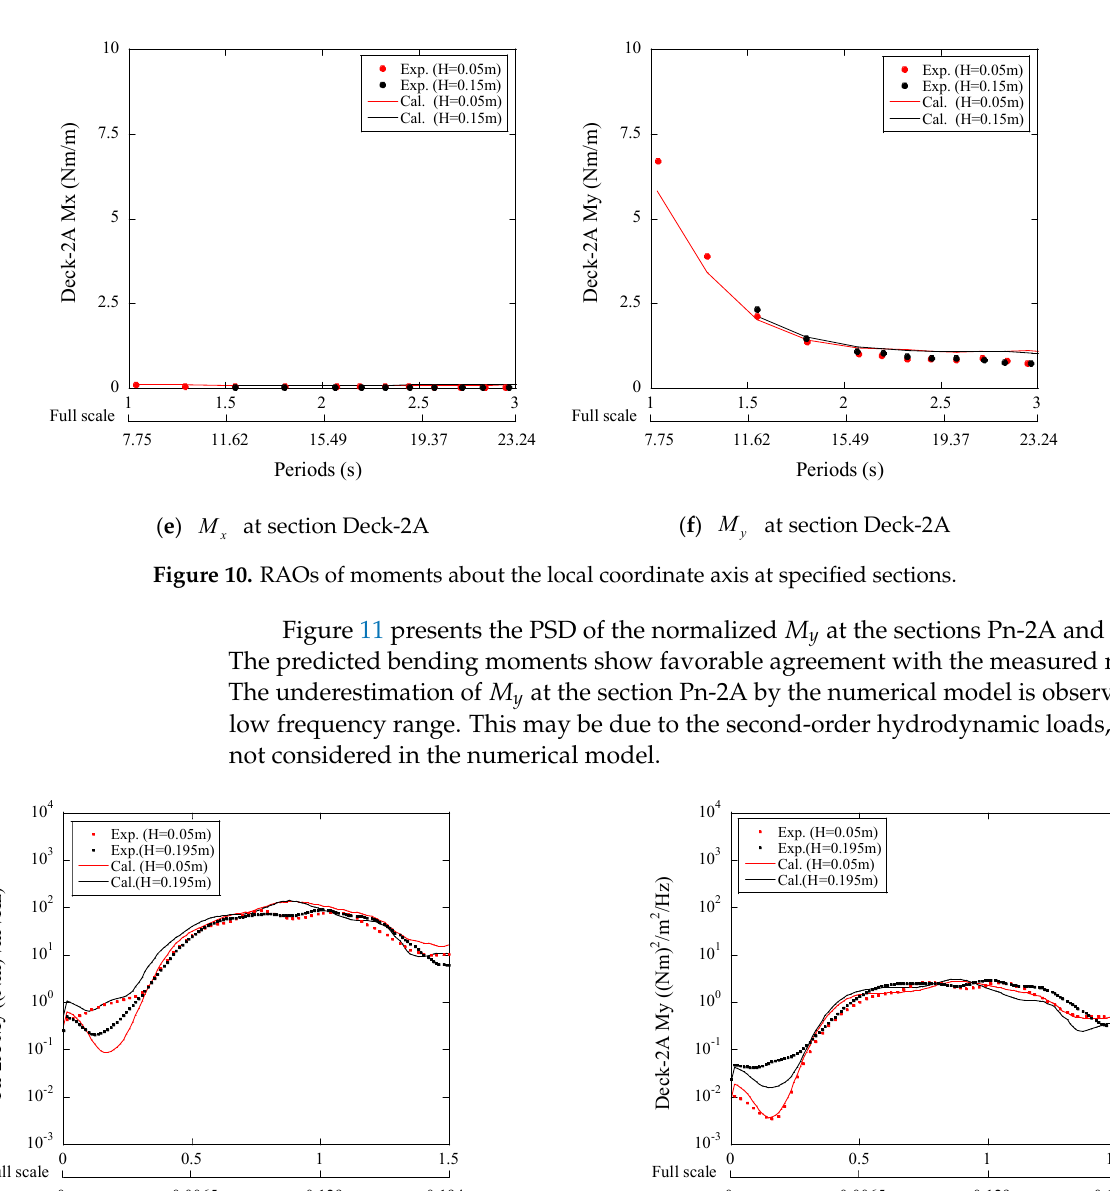
beam close to center column, M 0